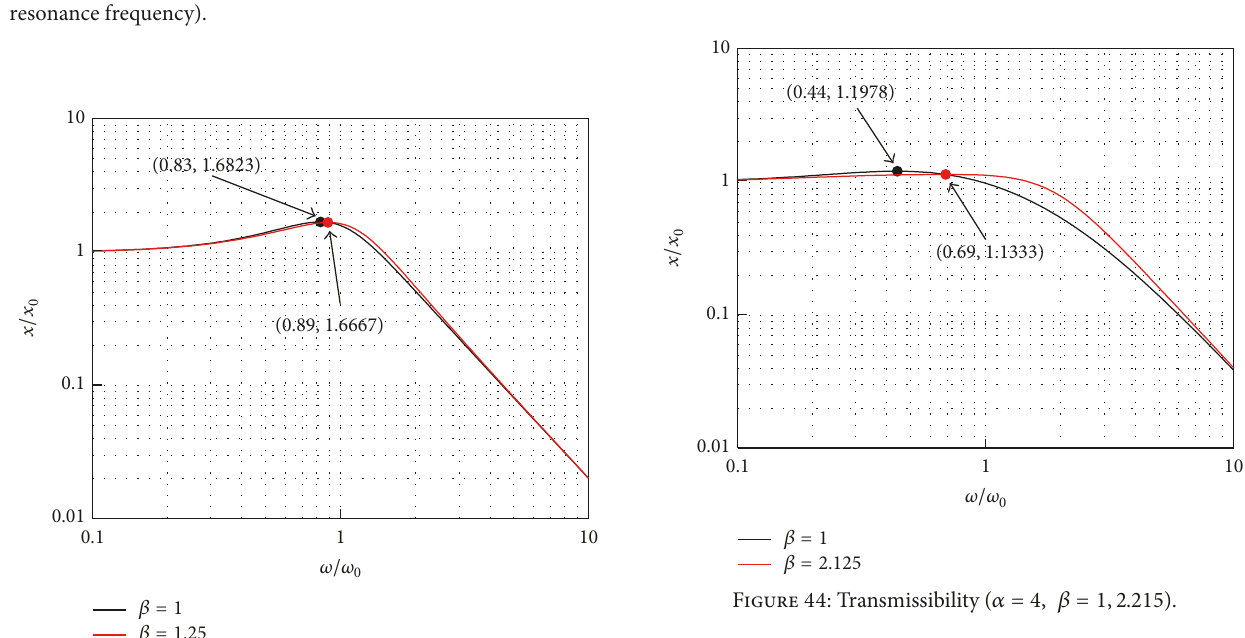
Figure 41: Response in the time domain ( 𝛼 = 4, 𝛽 = 1, 2.125 , at resonance frequency).